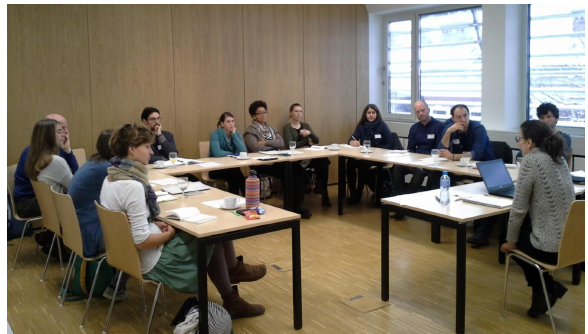
Figure 1. Workshop participants listening to a lecture given by a senior